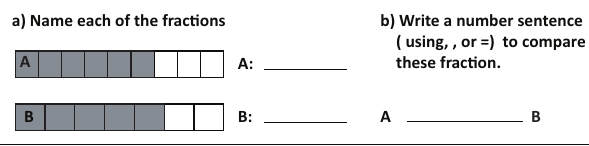
FIGURE 1: Fraction worksheet